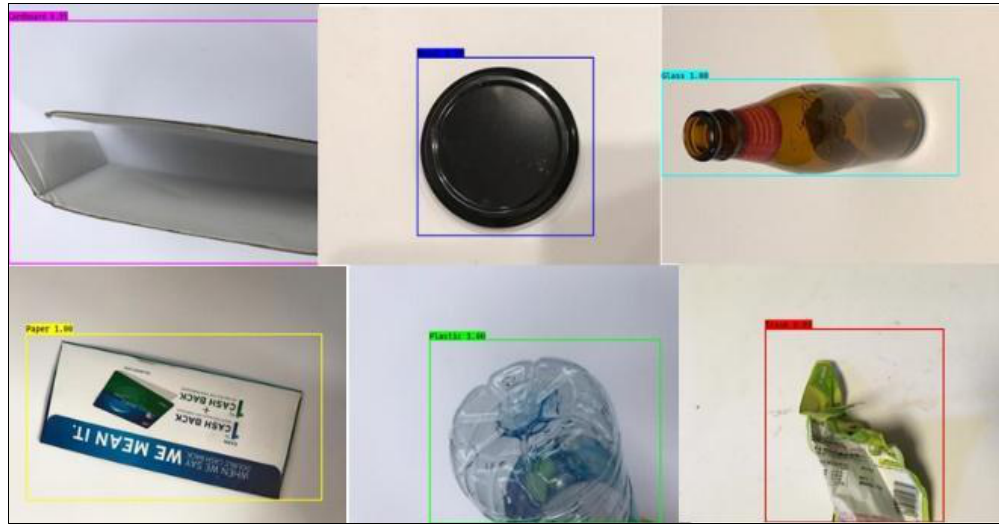
Figure 14. Objects detected by using the YOLO